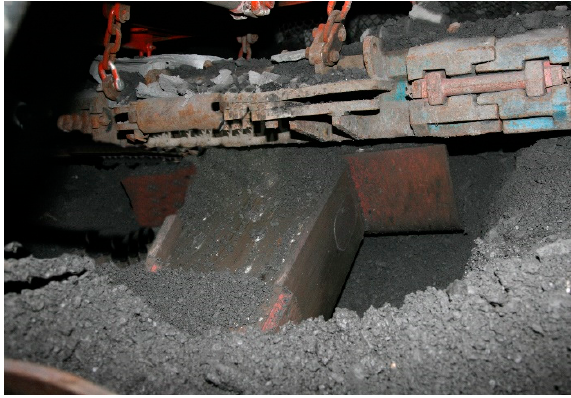
Figure 15. Working conditions of a hydraulic support in solid backfill mining.